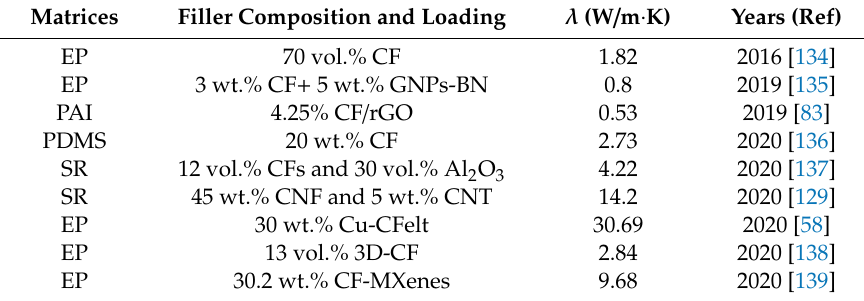
Figure 10. ( a ) Schematic diagram of the SCFNA method for the preparation of the PDMS/SCF/glass bubbles (GB) composites. ( b ) λ and ( c ) elongation-at-break of the PDMS/SCF/GB composites at different thicknesses of sample. ( d ) The thermally conductive network conversion from “sand-like” to “stone-like” [132].